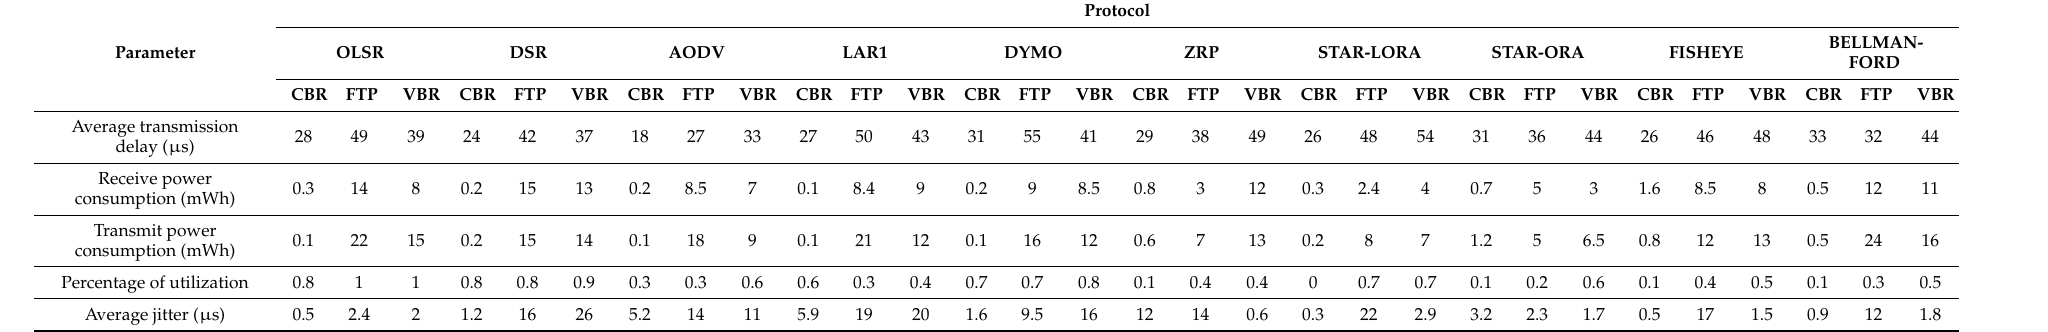
Table 2. Comparison of all routing protocols for 120